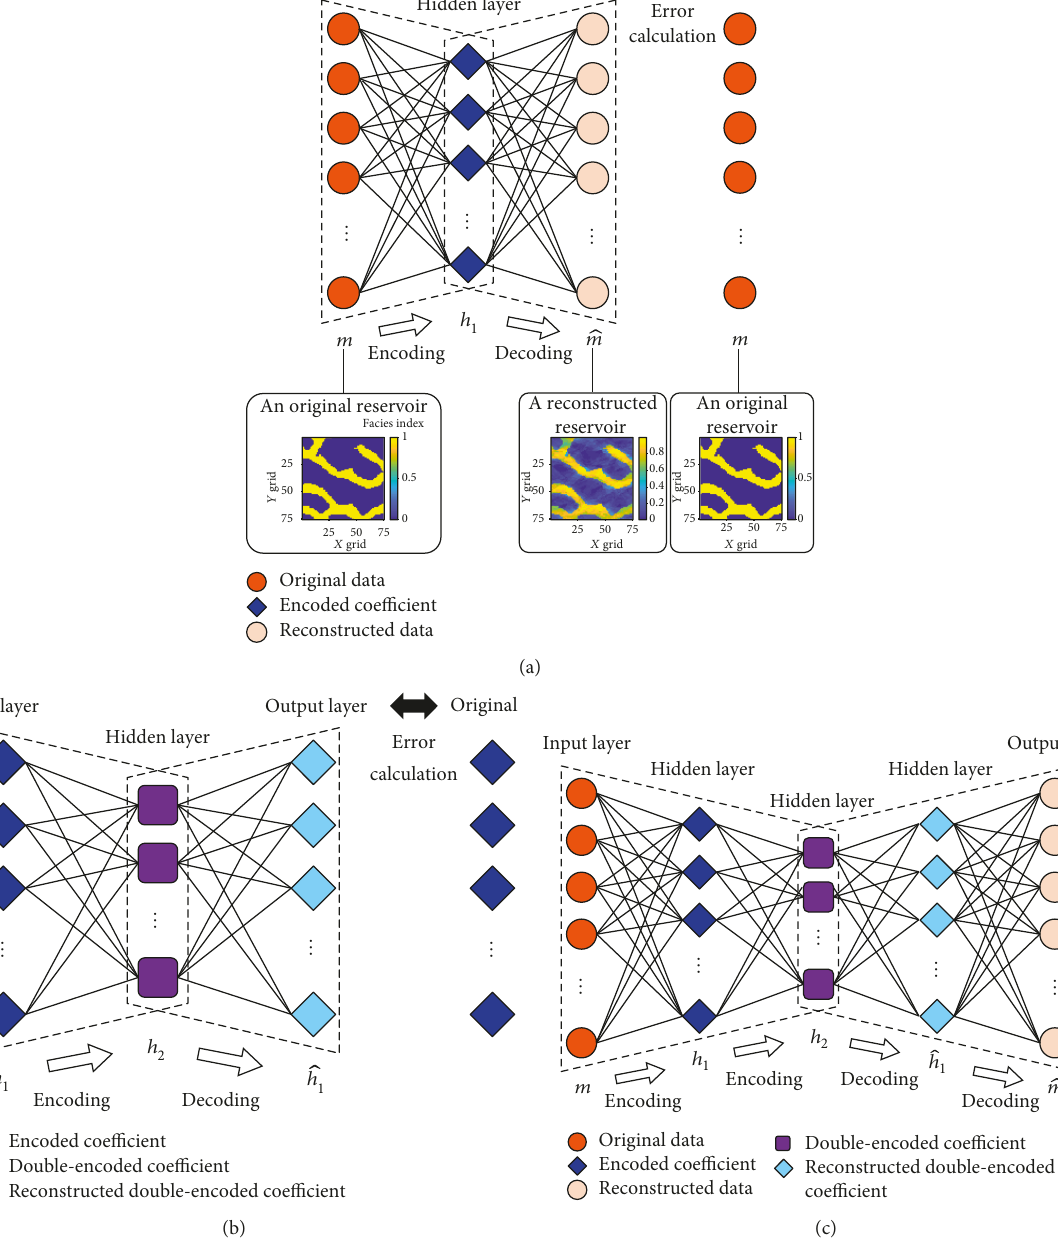
Figure 1: Two autoencoders (a) and (b) used to construct a stacked autoencoder